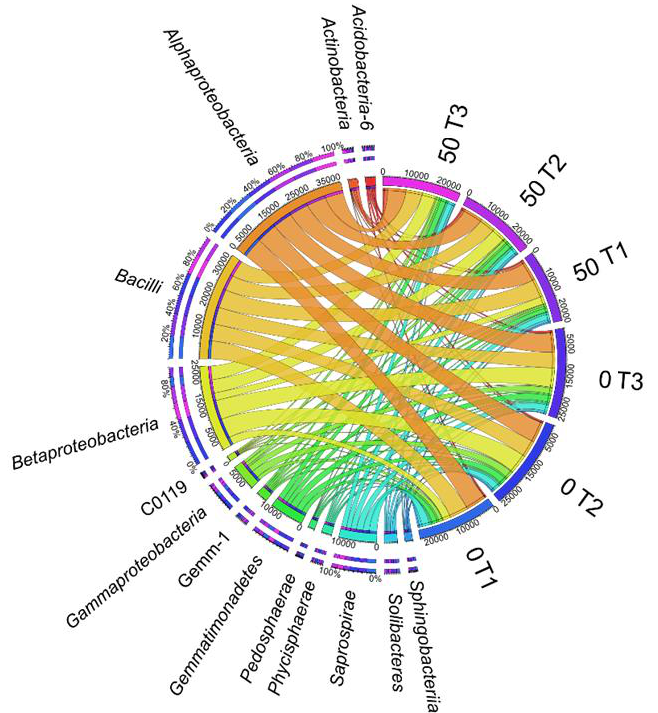
Figure 7. The relative abundance of dominant classes of bacteria in soil with a difference between proportions ≥ 1%. 0; 50—doses of o -cresol (mg kg − 1 DM of soil); T1—15th day, T2—30th day, T3—45th day of research.